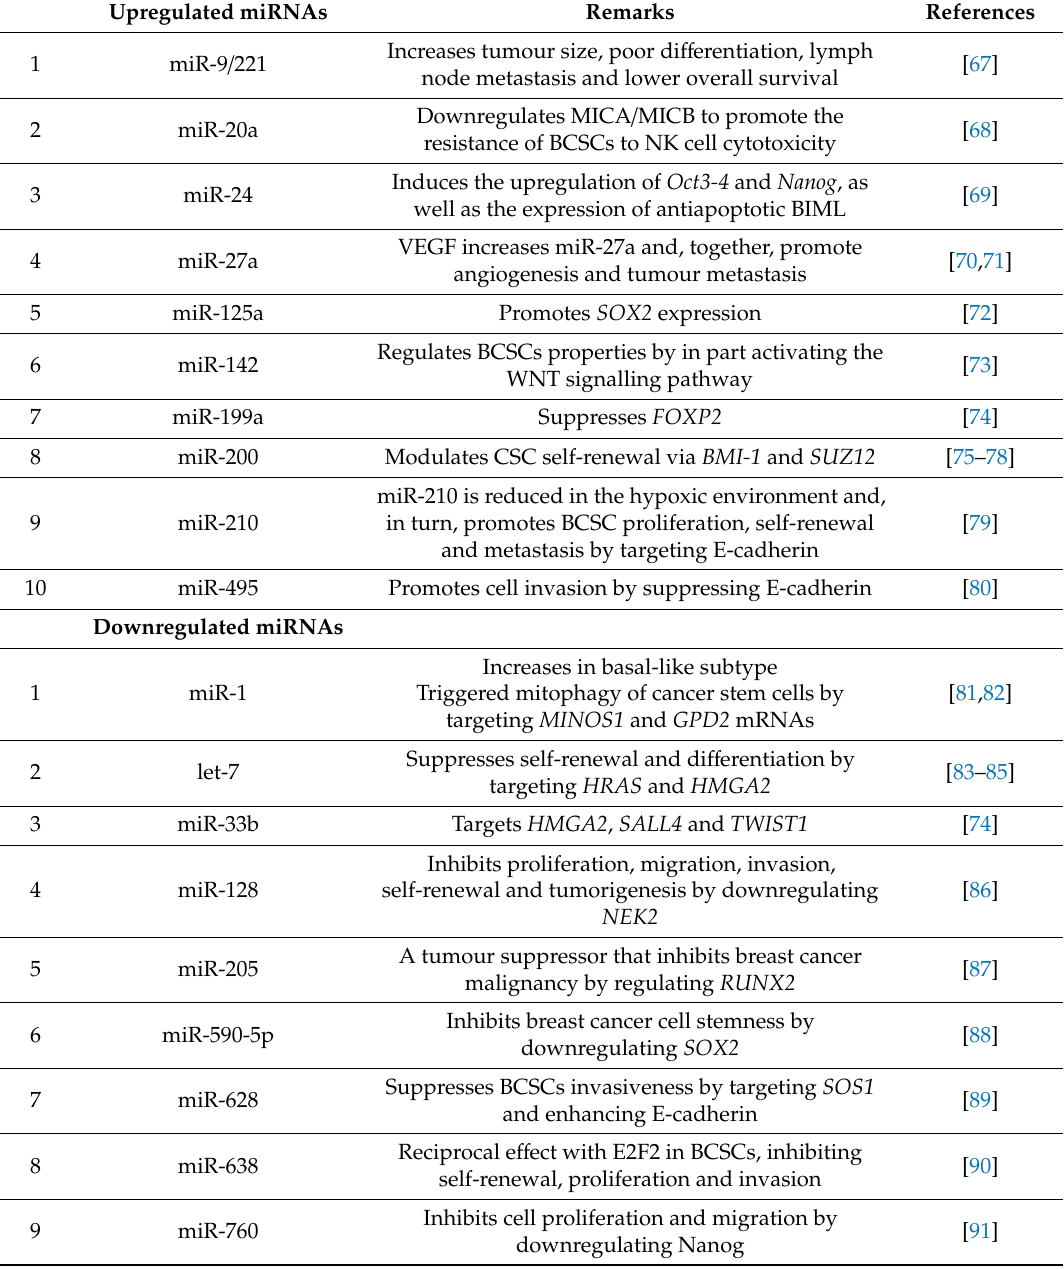
Table 1. MicroRNAs associated with the regulation of breast cancer stem cells. Upregulated